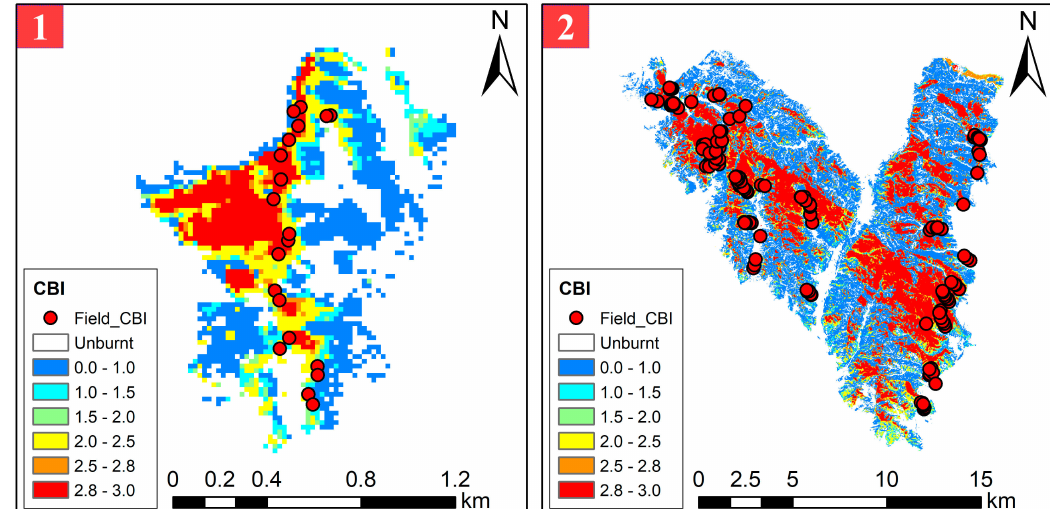
Figure 8. Burn severity maps for study sites 1 (left) and 2 (right) of Qinyuan fires achieved using the CP_RTM + TCC method proposed in this study. In order to show the spatial distribution characteristics of burn severity in the two study sites more finely, CBI was divided into six grades which vary from 0 to 3.